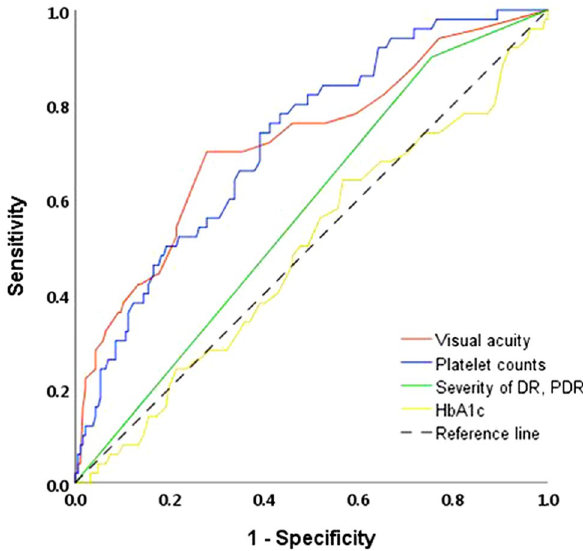
Figure 1. The validation of diagnostic performance between visual acuity and platelet counts. The area under the receiver operating characteristic curve (AUROC) of the visual acuity was 0.728 ( P < 0.001, CI 0.645–0.811) and platelet counts was 0.722 ( P < 0.001, CI 0.648–0.796). The cut off point of a high likelihood of DR progression was visual acuity, 0.505 (sensitivity: 71.2; specificity: 71.7) and platelet counts, 253 (× 103/uL) (sensitivity: 75.0; specificity: 61.2).